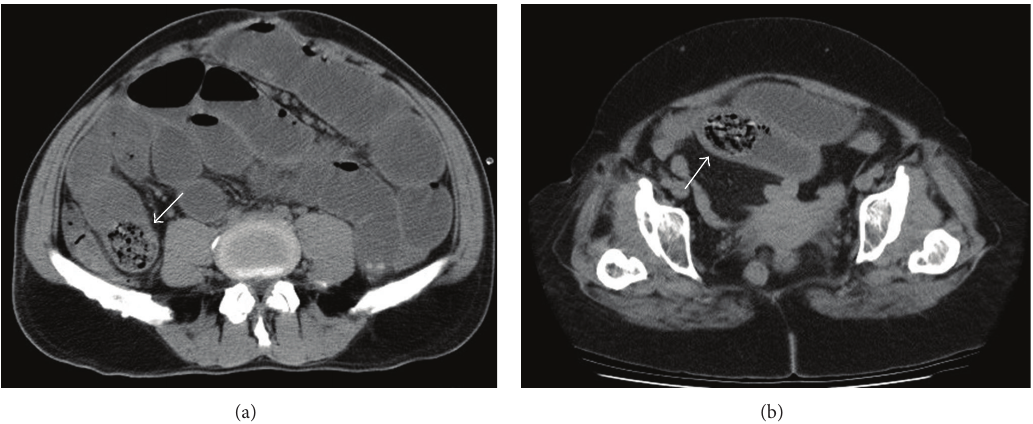
Figure 2: 52-year-old female patient (a) and 62-year-old female patient (b) had an intraluminal round bezoar with a mottled gas pattern (arrows).